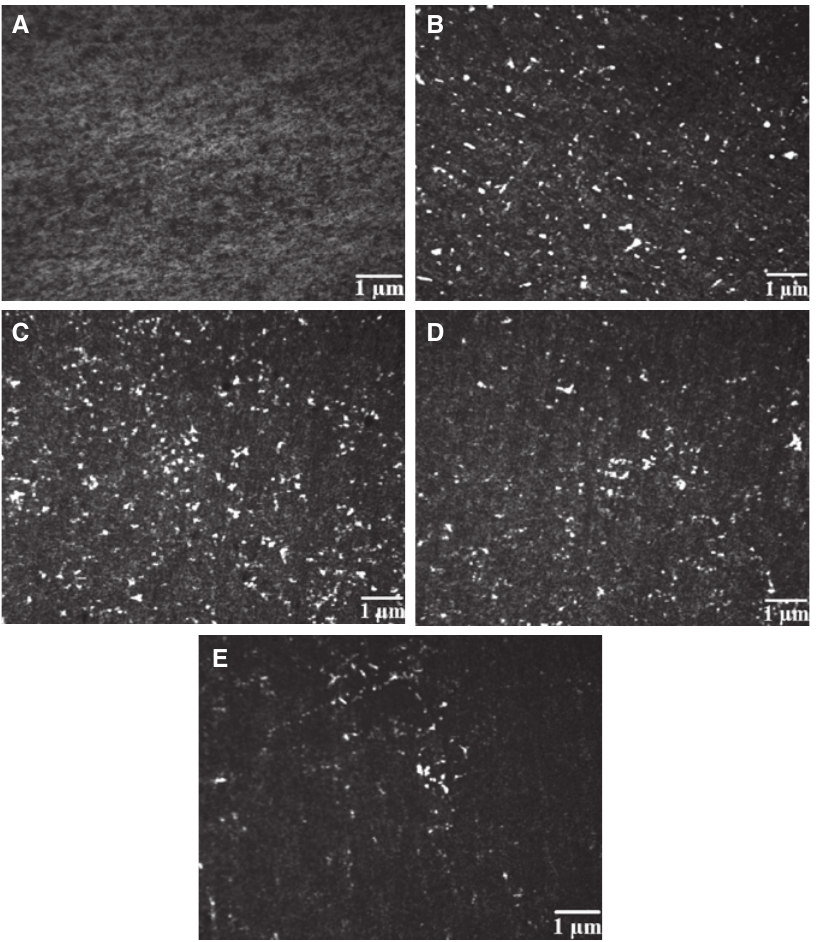
Figure 5: Microstructures of (A) unreinforced Al alloy (B) homogeneous composite (C) FGM – outer surface (D) FGM – middle surface and (E) FGM – inner surface.